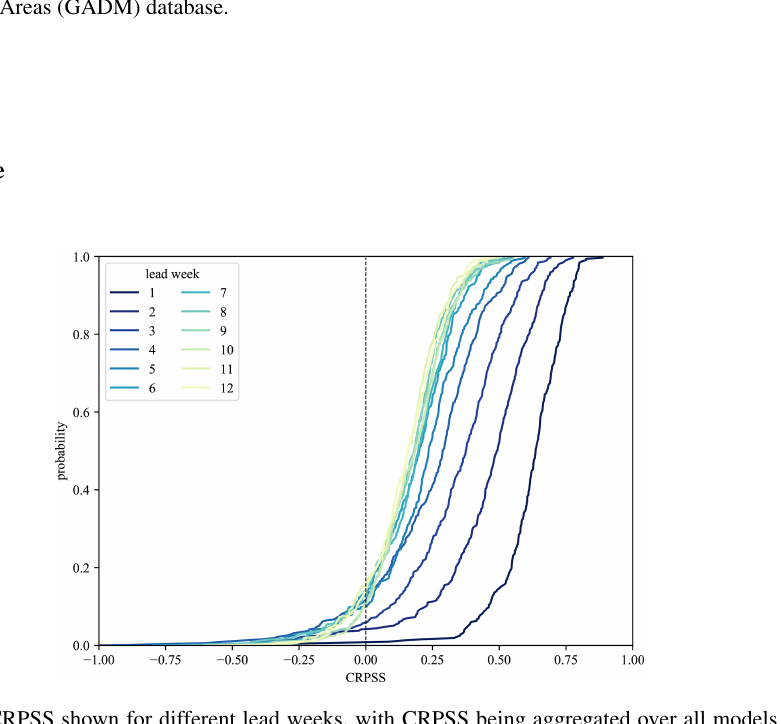
Figure B1. CDFs of weekly CRPSS shown for different lead weeks, with CRPSS being aggregated over all models and stations for fresh surface water level hindcasts (rivers, streams, and